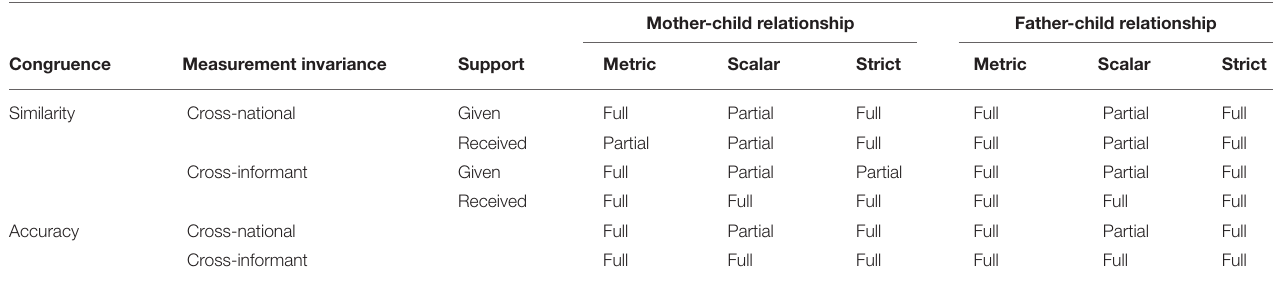
TABLE 10 | Cross-national LCM measurement invariance scenarios and findings on the illustrative